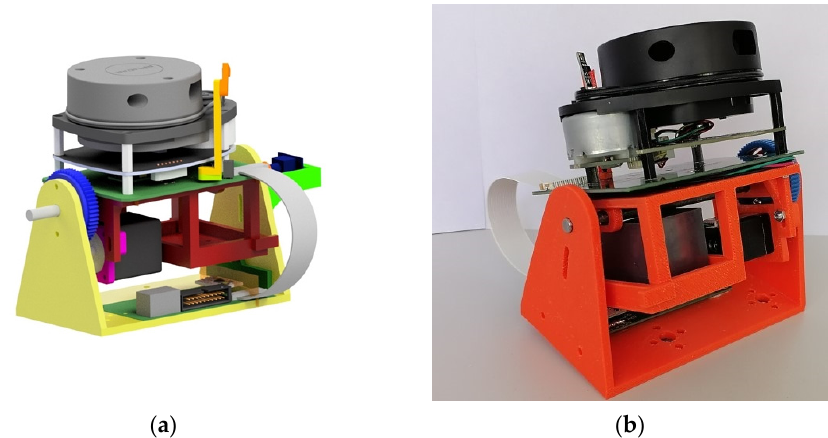
Figure 2. ( a ) Visualization of the scanning mechanism; ( b ) prototype of the scanning mechanism manufactured by 3D printing.